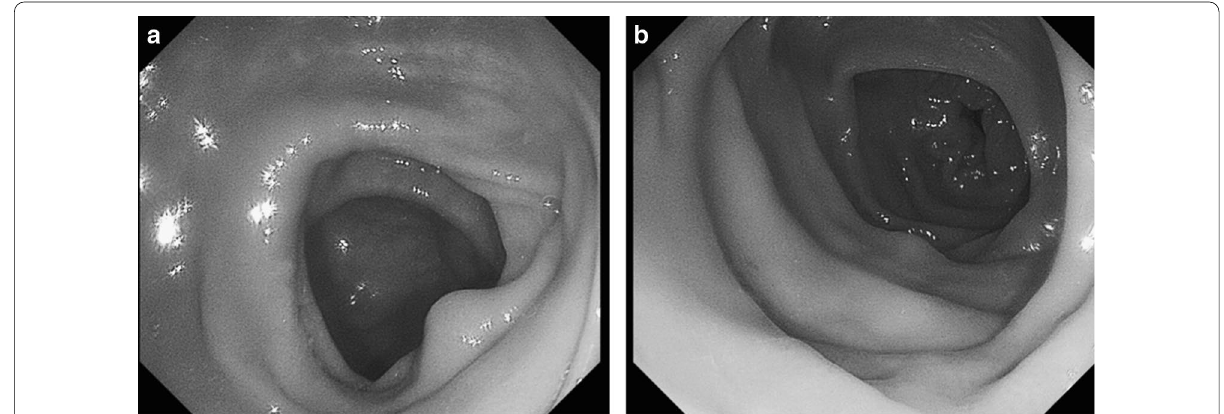
Fig. 1 Total colonoscopy. Although mucosal edema is observed in several portions, no mechanical obstruction or stenosis was found from the cecum ( a ) to the rectum ( b